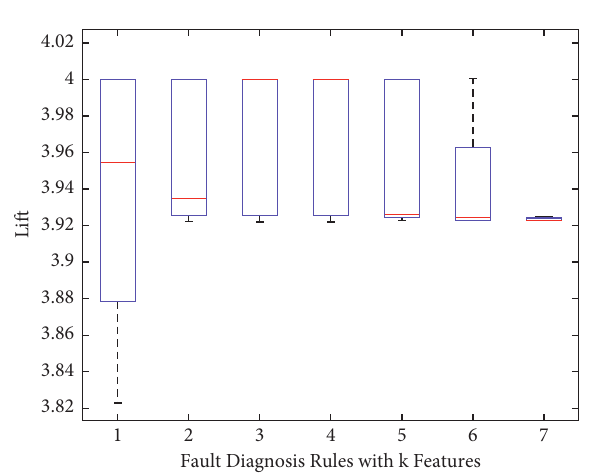
Figure 17: Lift boxplot.